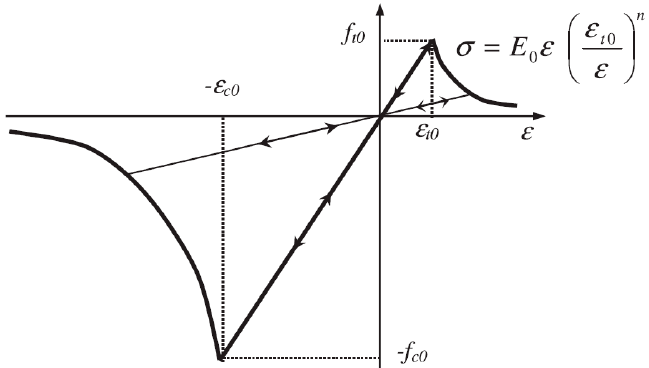
Figure 1. Elastic damage-based constitutive law of elements under uniaxial stress.